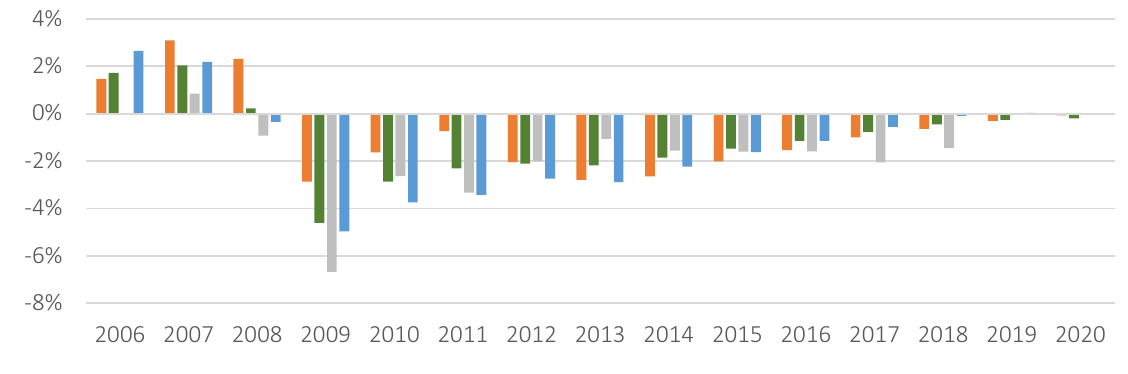
Source: Built by the authors on the results of the